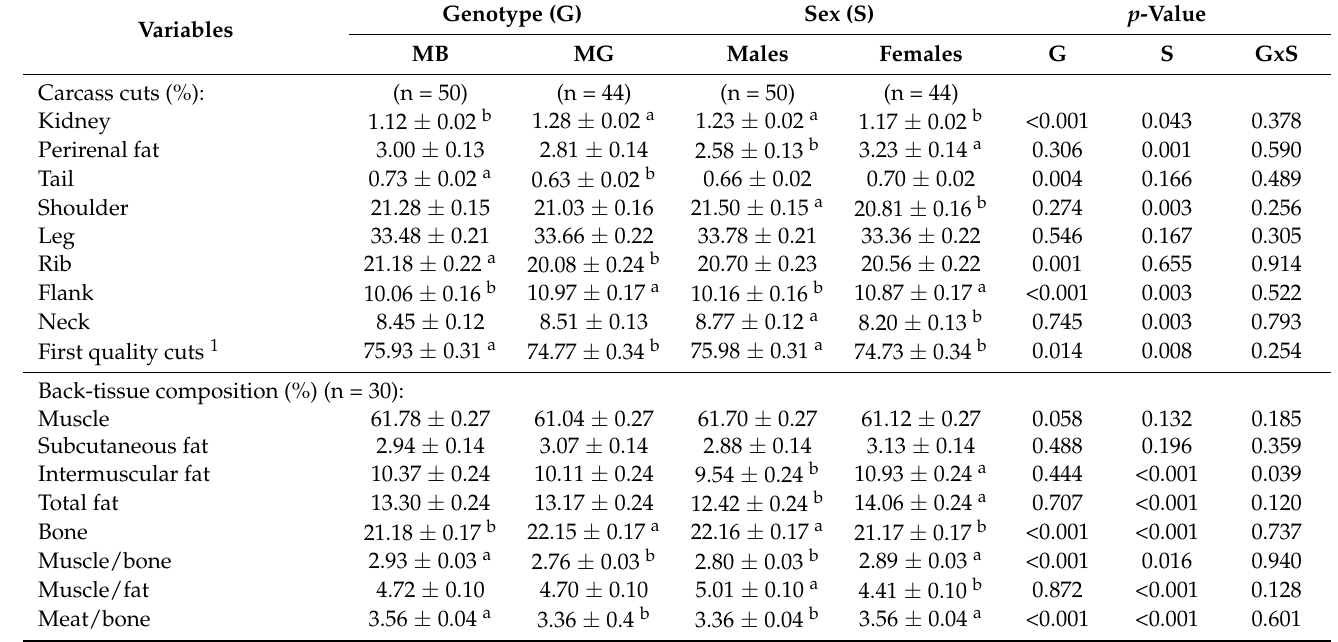
Table 4. Least-square means ( ± SE) for the carcass cuts as a percentage of the half carcass and for back-tissue composition in kids according to genotype (purebred Murciano-Granadina (MG) or crossed with Boer (MB)) and